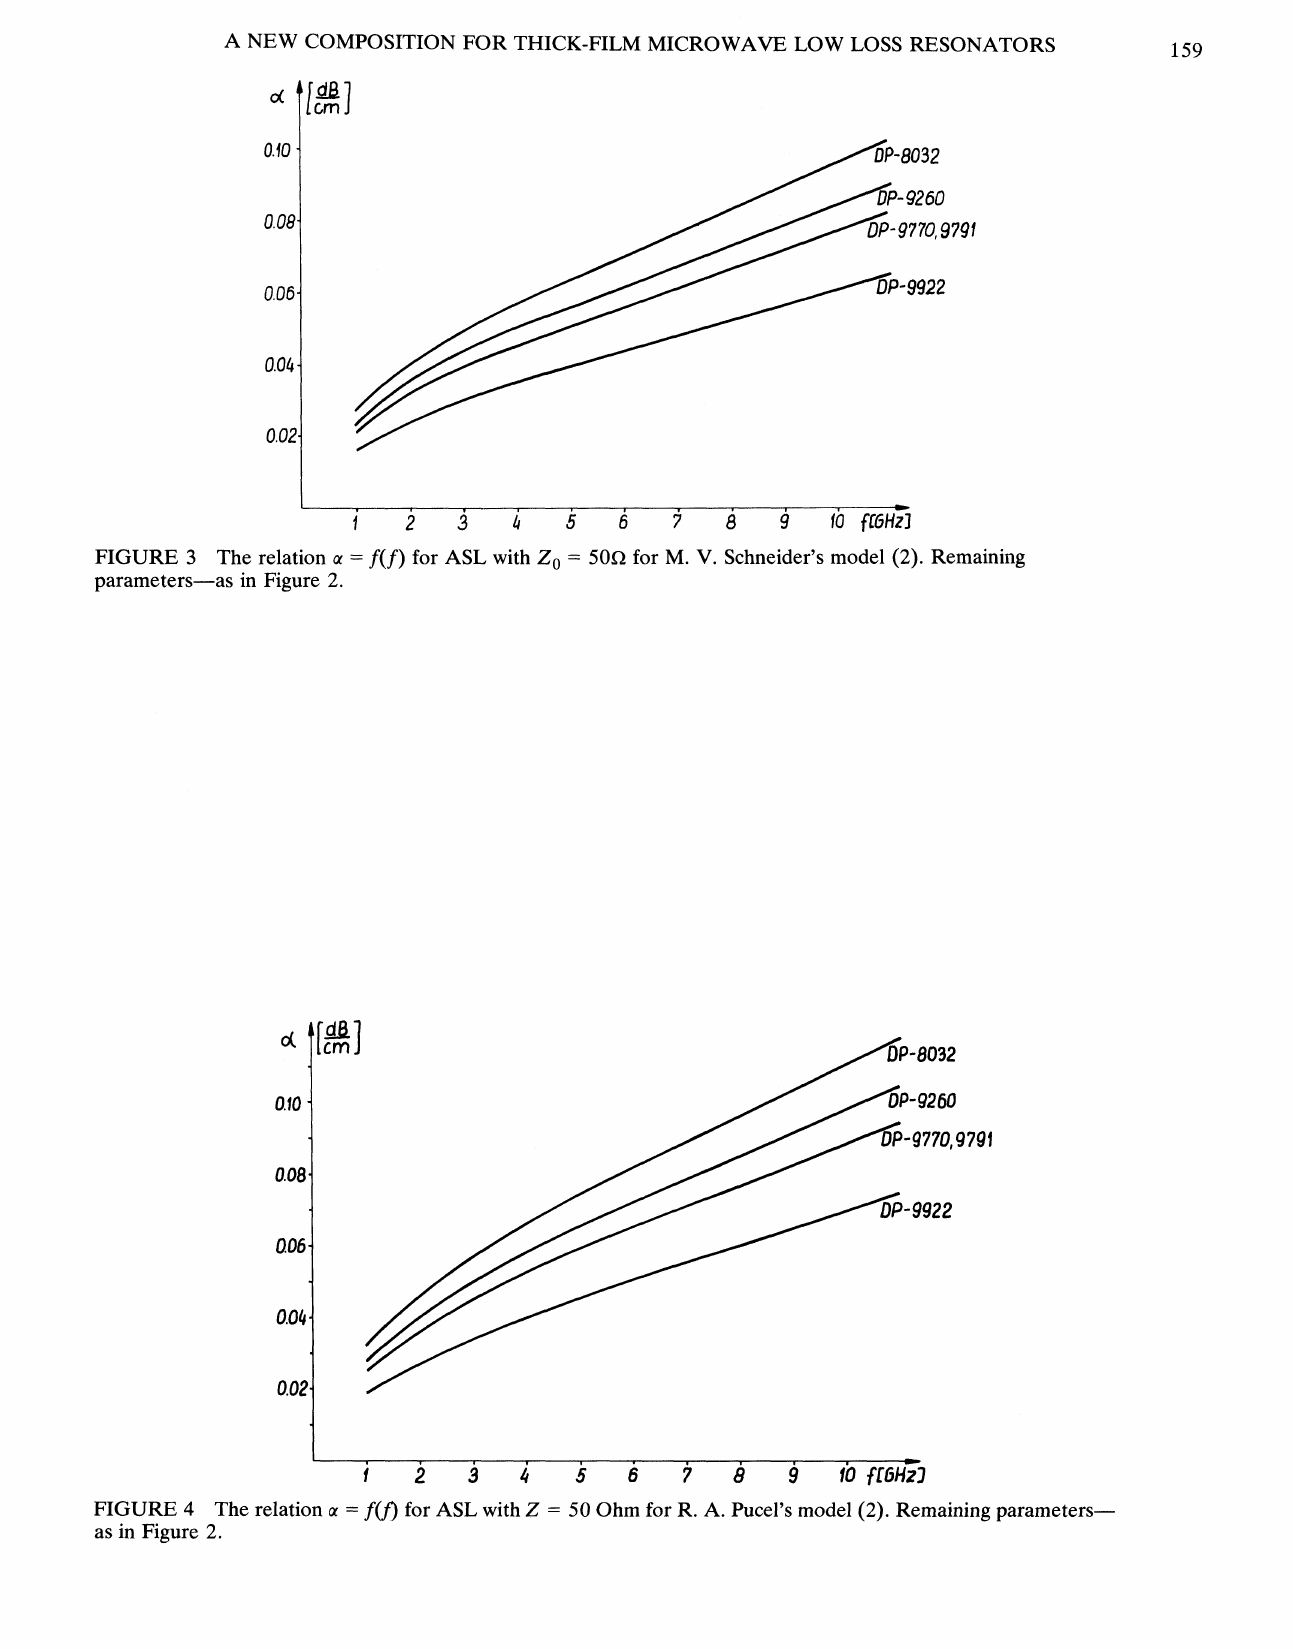
FIGURE 4 The relation f(f) for ASL with Z 50 Ohm for R. A. Pucel’s model (2). Remaining parameters-- as in Figure